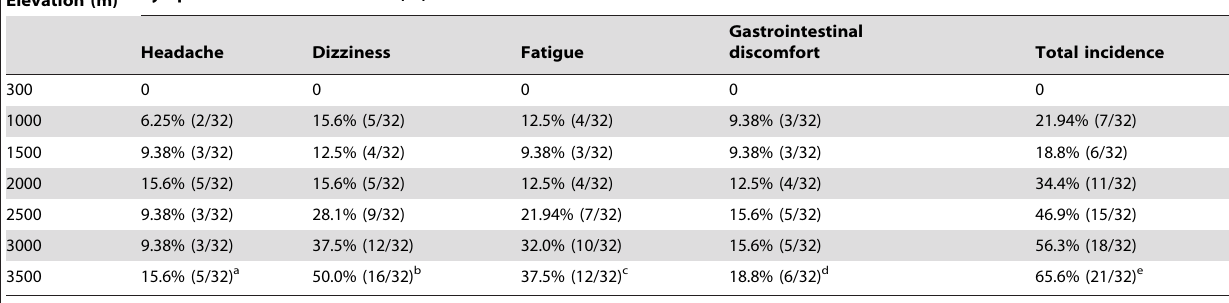
Elevation (m) Symptoms and incidence rate (%)